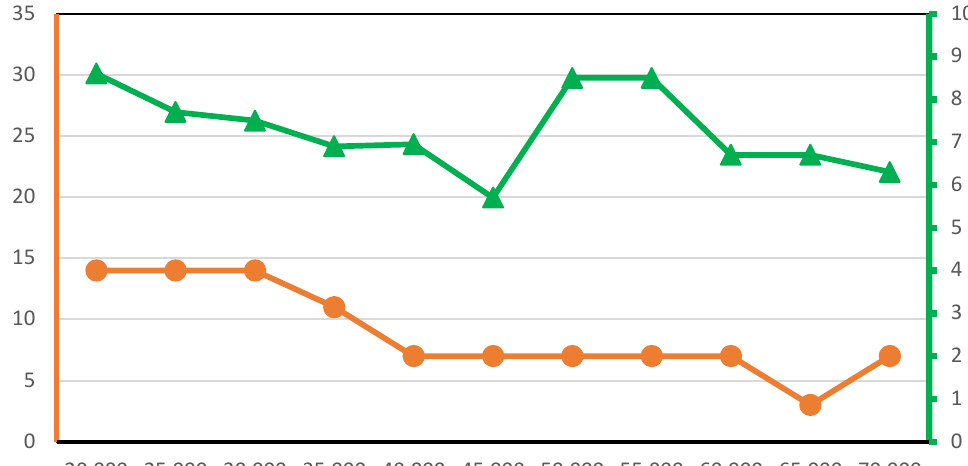
Figure 16. Elaboration time and number of aggregates as a function of the required power variation.